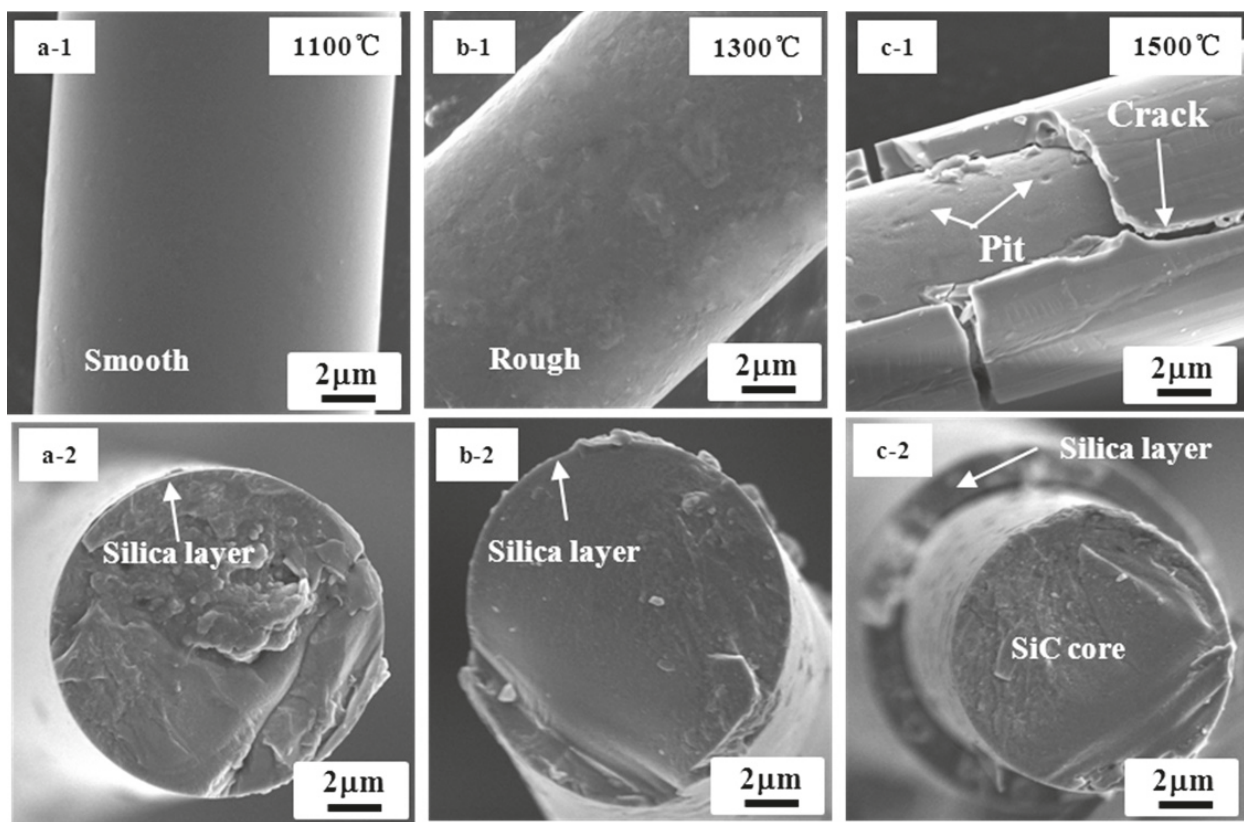
Figure 4: SEM graphs of KD-S fibres after annealing under simulated atmospheres for 1 h. (a) At 1100 ∘ C, (b) at 1300 ∘ C, and (c) at 1500 ∘